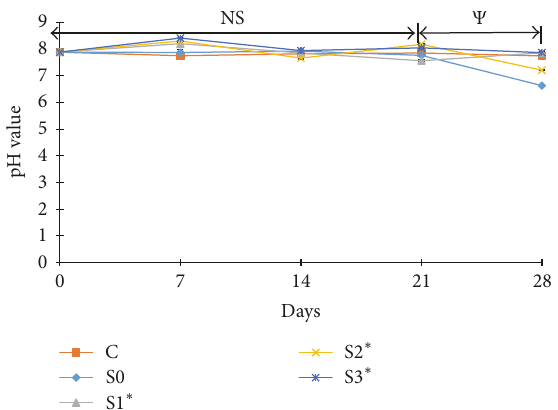
Figure 11: The DMEM pH profiles incubated with infused car- rageenan 3D scaffold (S0, S1, S2, and S3 and control media without scaffold (C)) for 7, 14, 21, and 28 days. The experiments were carried out in triplicate ( 𝑛 = 3 ). ∗ Ψ ( 𝑝 < 0.05 ): significantly different as compared to S0. NS: not